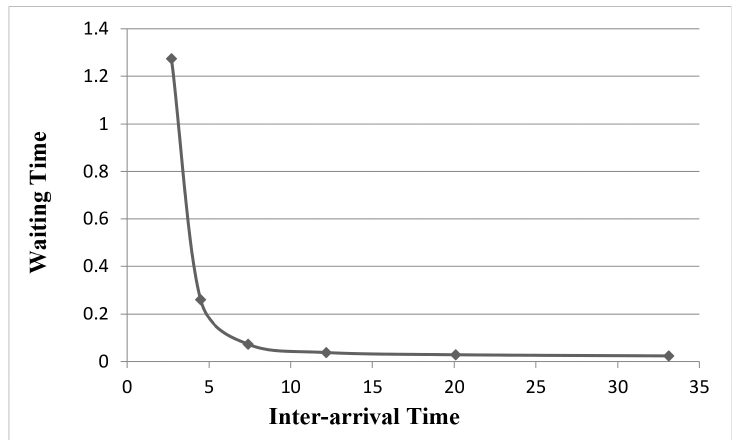
Figure 3. The impact of request arrival on holding time